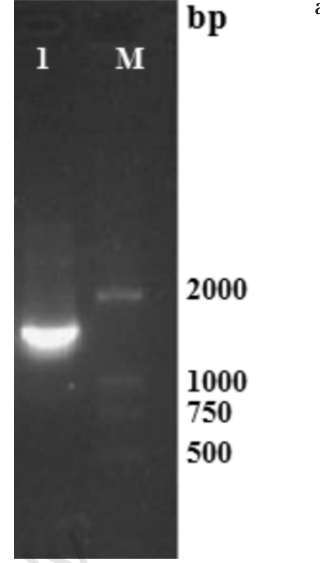
Figure 1. 16S rDNA amplicon of Bacillus halodurans . Lane M: -1 kb DNA Ladder. Lane 1: Amplicon of 16S rDNA (1,502